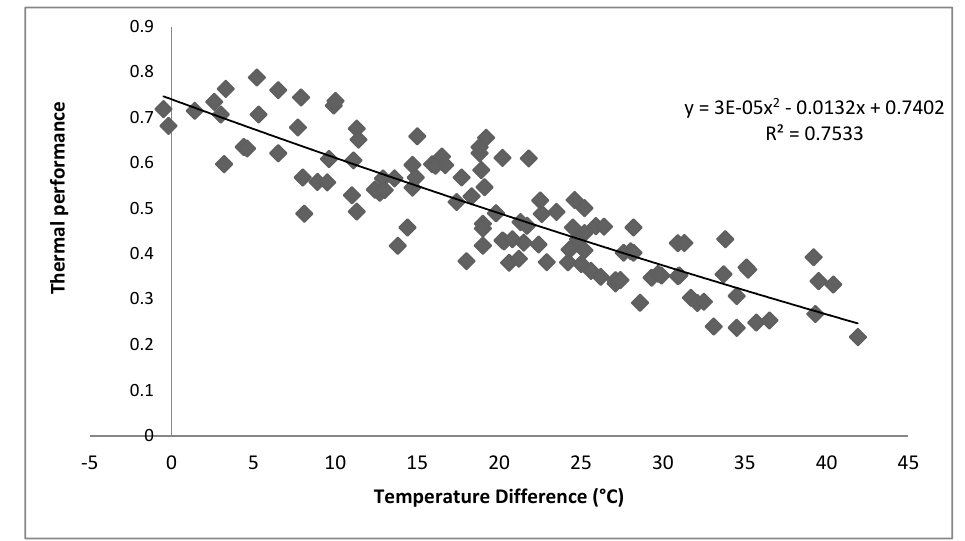
Figure 4. Thermal yield of the solar water-heating module.